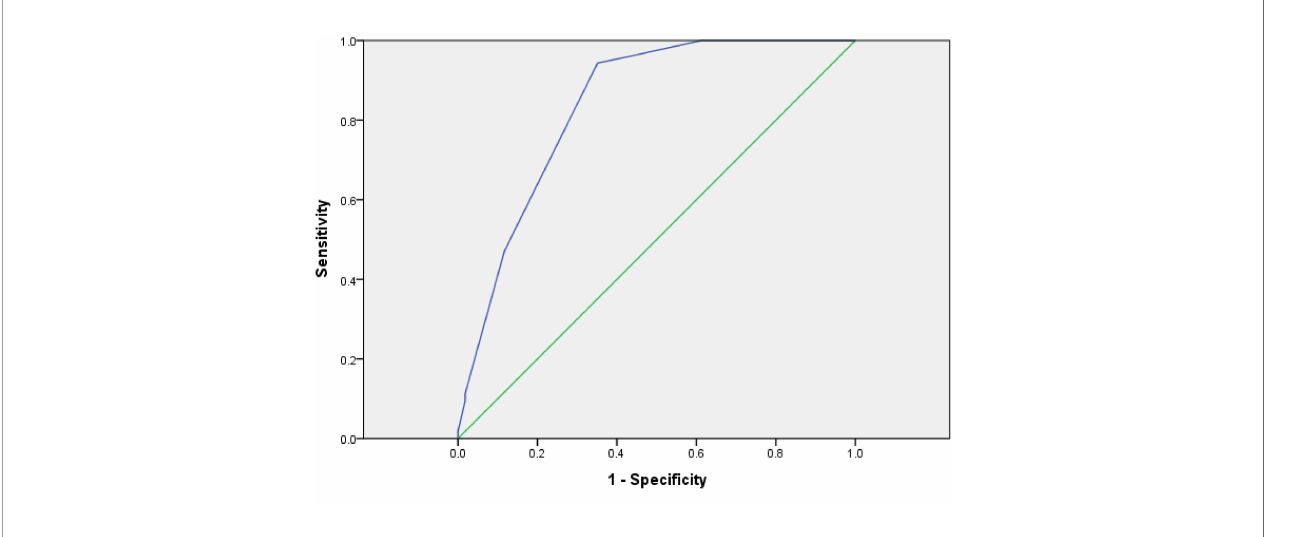
FIGURE 4 | Validation group risk score ROC curve.